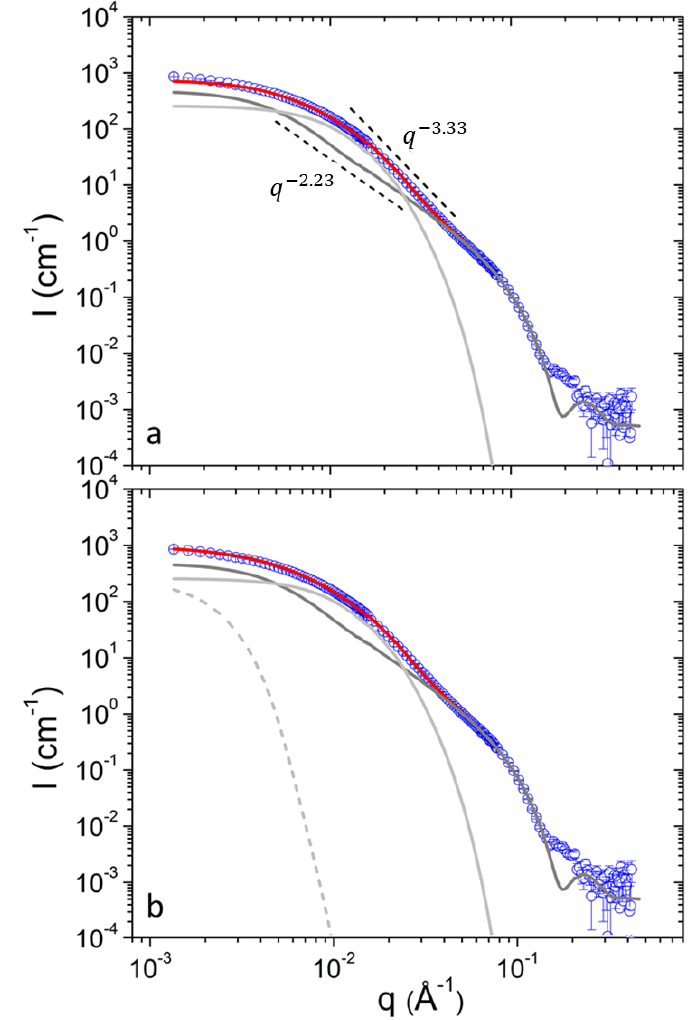
Figure 1. ( a ) SANS profiles from DPPC/PEO-b-PCL1 at 30 (black) mg mL − 1 at 25 ◦ C. Red line is the best fit with equation 1. Light gray and dark gray lines correspond to contributions from aggregates I agg and vesicles I ves respectively. Characteristic power-law trends are indicated by dashed lines. ( b ) Fitting the data of ( a ) using the additional term I clust (dashed line).